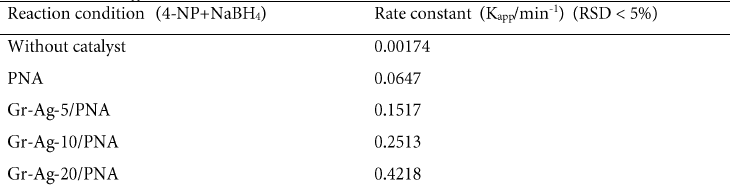
Fig.8. CV plots recorded without and with 4-NP (0.1 mM) in phosphate buffer in 50 mV/s over Gr-Ag-20/PNA/CPE (a) and CV plots recorded with 0.1 mM 4-NP at a scan rate of 50 mV/s over bare CPE, PNA/CPE and Gr-Ag-20/PNA/CPE (b) Table 3.1. The k values calculated for the reduction of 4-NP under different catalytic app